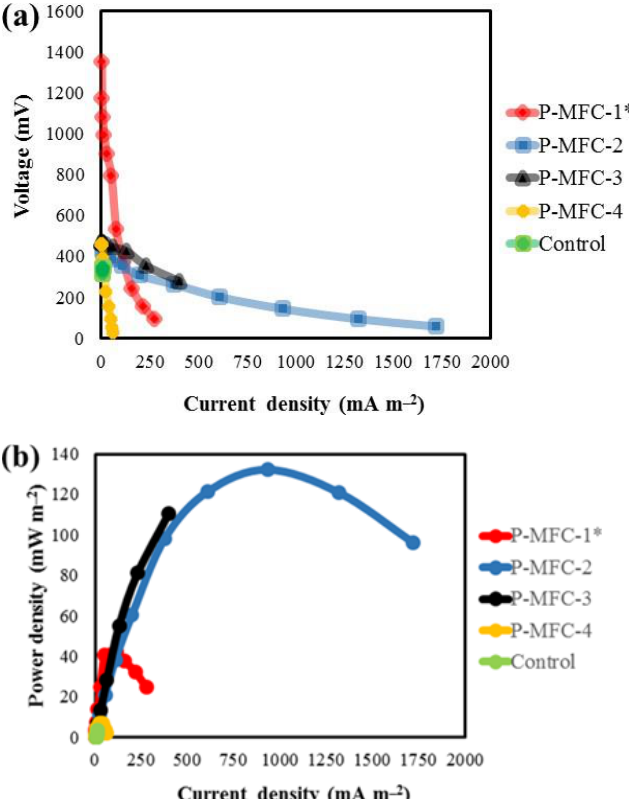
Figure 3. Results of ( a ) polarization curves, and ( b ) power – density curves were performed during the experiment.